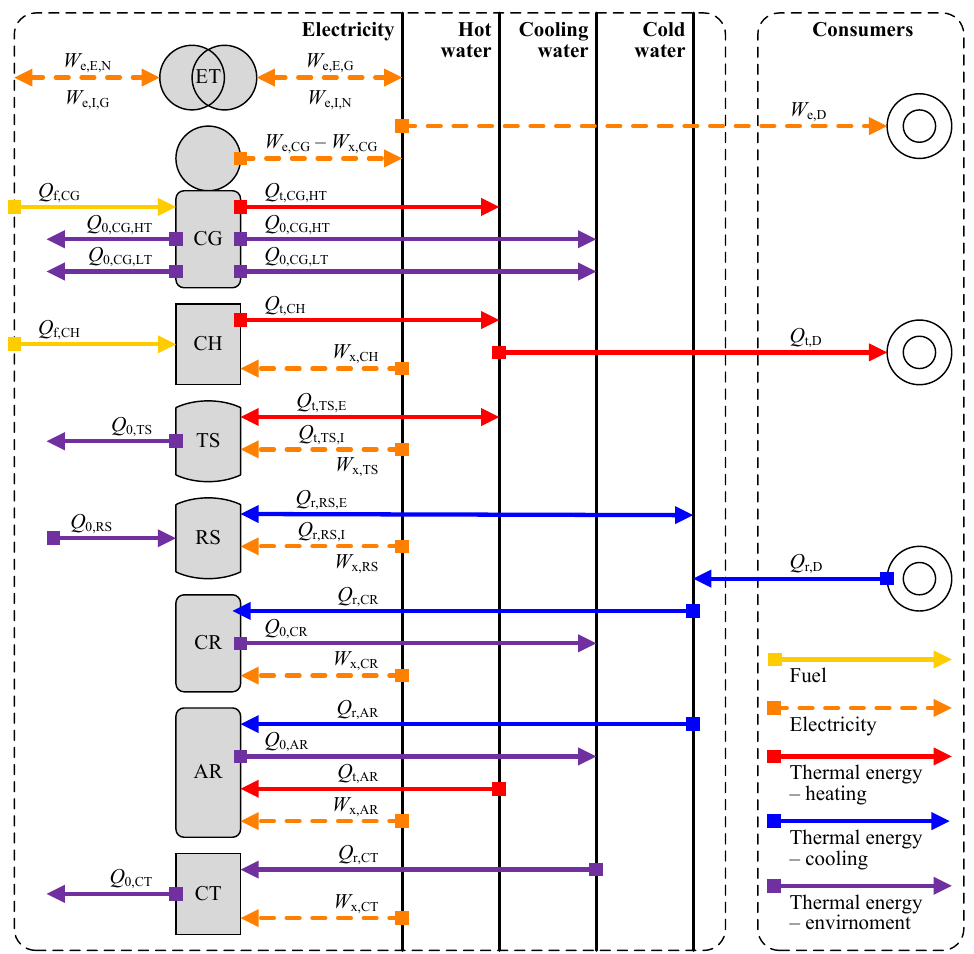
Figure 1. Main system components and energy